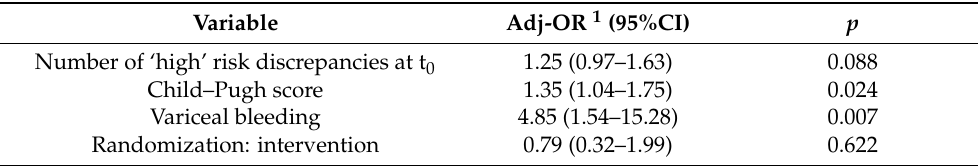
Table 5. Adjusted odds of having ≥ 1 unplanned medication-related hospital